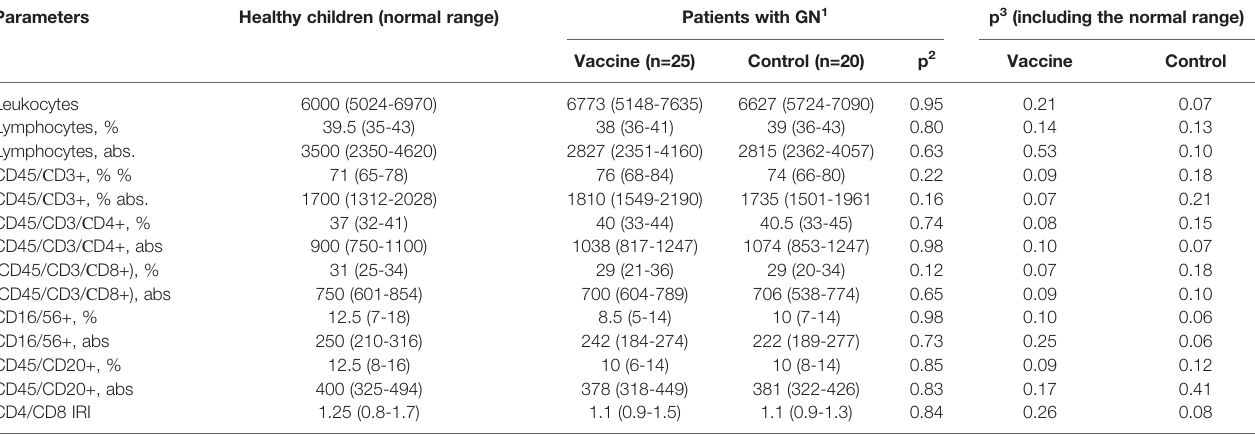
TABLE 2 | Comparative characteristics of peripheral blood lymphocytes subpopulation structure in children with GN and healthy ones aged 7-15 years.